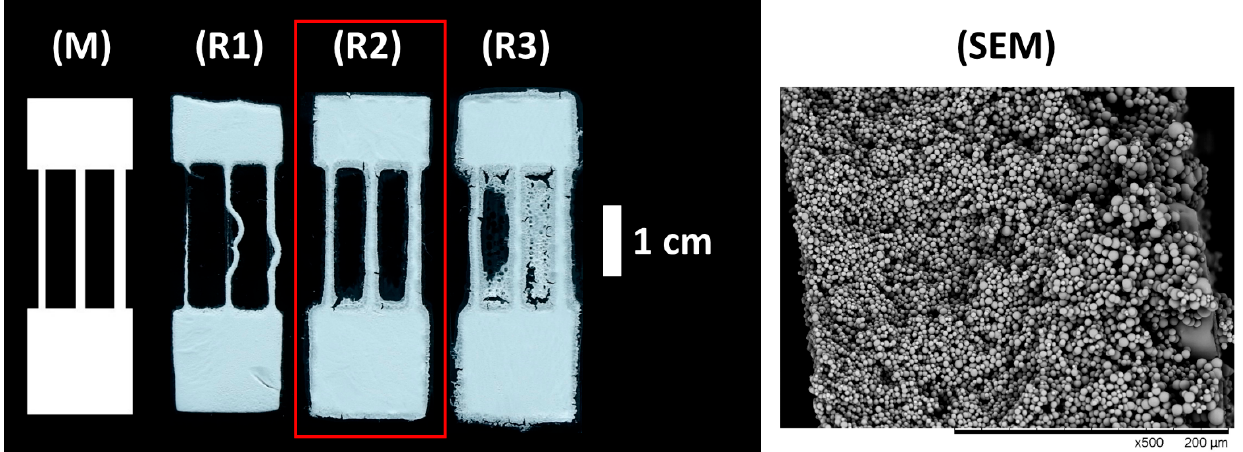
Figure 1. The mask used for PL experiments (M), the resulting pattern of the monolithic thiol–ene polymer sheet with different curing times ( R1 – R3 ), and SEM micrographs of the cross-section of the material. The channel widths of the mask from left to right are as follows: 0.9 mm, 1.2 mm, 1.5 mm. The length of the channels is 2 cm and the length of the whole shape is 4.5 cm. The width of the shape is 1.5 cm. The curing times were 45, 65 and 80 s for ( R1 – R3 ), respectively. The conditions used for print ( R2 ), highlighted with the red box, were found to be optimal for PL.